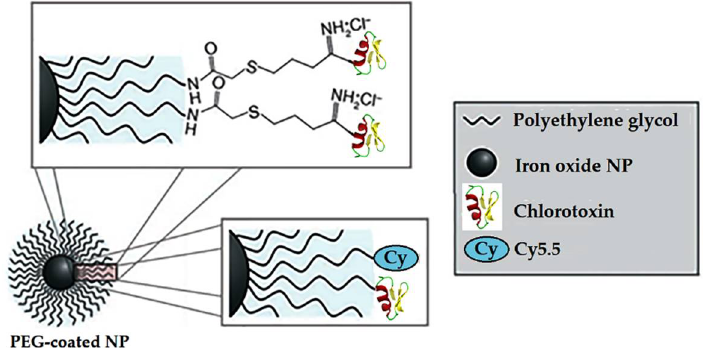
Figure 7. Schematic illustration of MNPs functionalized with clorotoxin and